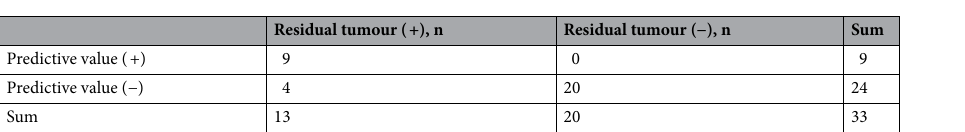
Table 3. Correlation between positive and negative predictive values of the combination of novel tumour markers and the presence or absence of a residual tumour.